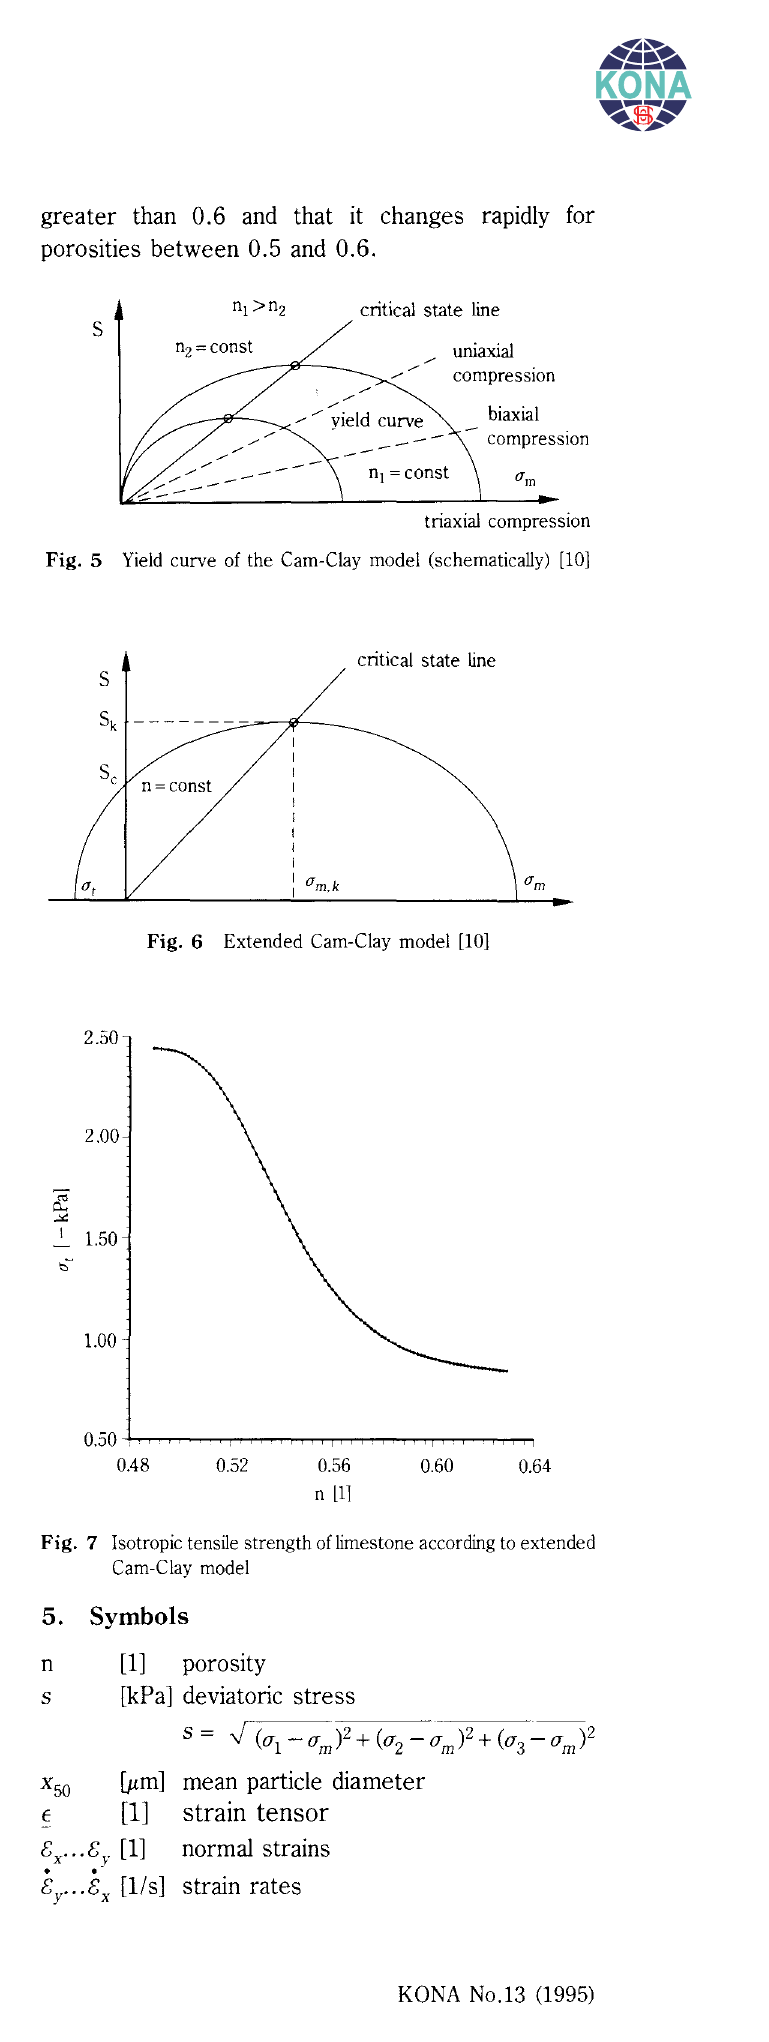
Fig. 7 Isotropic tensile strength of limestone according to